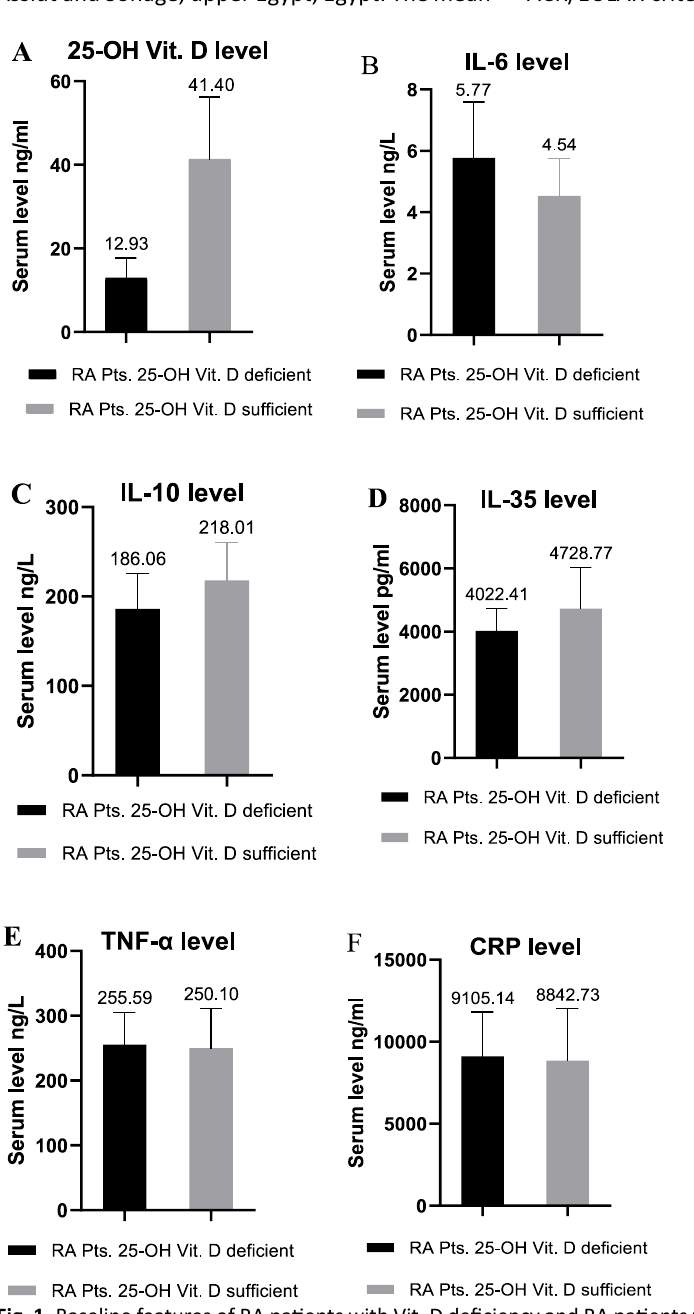
Fig. 1. Baseline features of RA patients with Vit. D deficiency and RA patients with Vit. D sufficiency. (A), IL-6 (B), IL-10 (C), IL-35 (D), TNF-α (E) and finally CRP